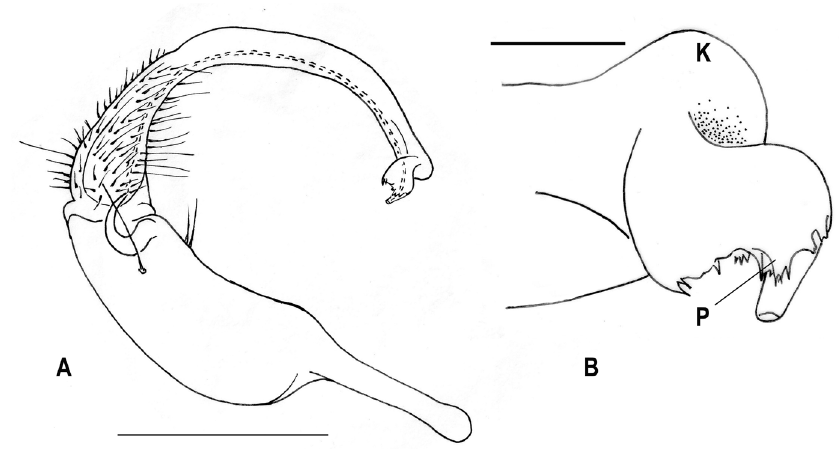
Fig. 9. Levizonus nakhodka Mikhaljova sp. nov., ♂, paratype (FSCB 72020). A . Gonopod, mesal view. B . Gonopod apex, mesal view. Scale bars: A = 1.0 mm; B = 0.1